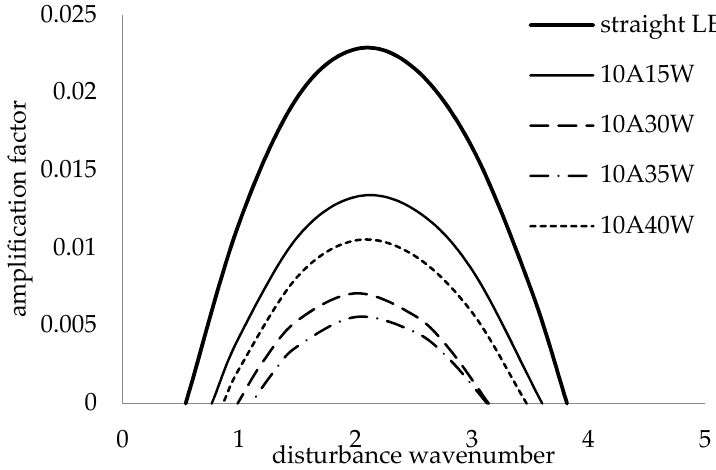
Figure 19. Amplification curves at fixed 2300 Reynolds number.